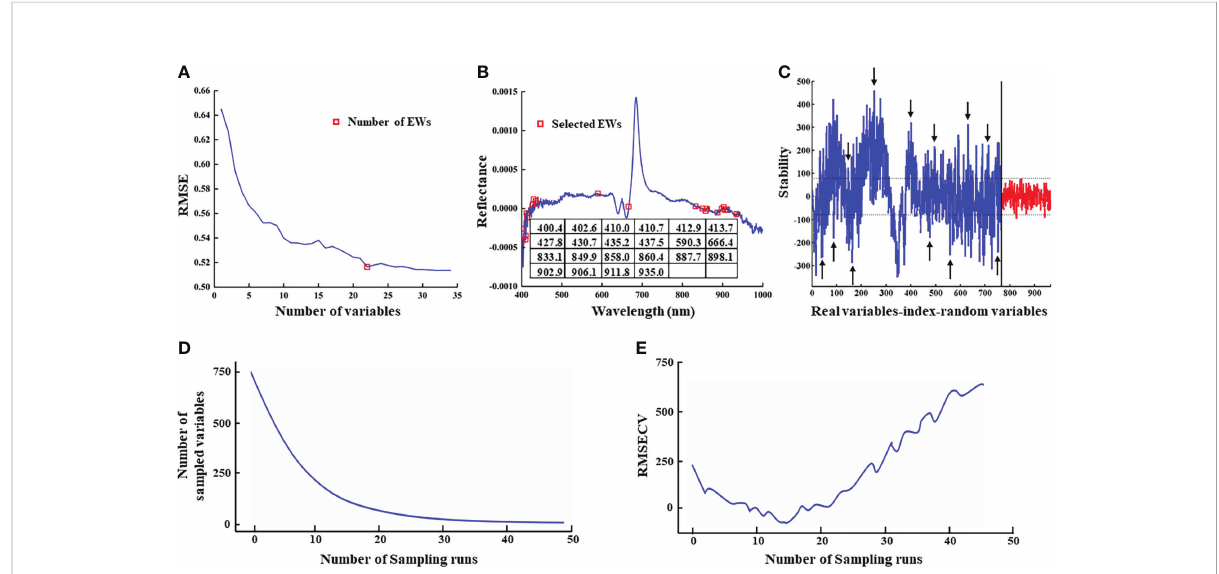
FIGURE 6 Results of EWs selection. (A) RMSE for the number of EWs by SPA; (B) The position of EWs identi fi ed by SPA in FD-processed spectrum; (C) EWs selected by UVE. Peaks in the blue curve represent stability values for the 765 wavelengths; the red curve shows the distribution of stability values of random noise variables generated by UVE which were used to determine the thresholds. The two horizontal dashed lines indicate the upper and lower thresholds of band selection. Bands between the thresholds were eliminated as invalid information, and the remaining variables were selected. The arrowheads show a few representative wavelengths; (D) Variation of wavelength variables number by CARS; (E) Variation of RMSECV by